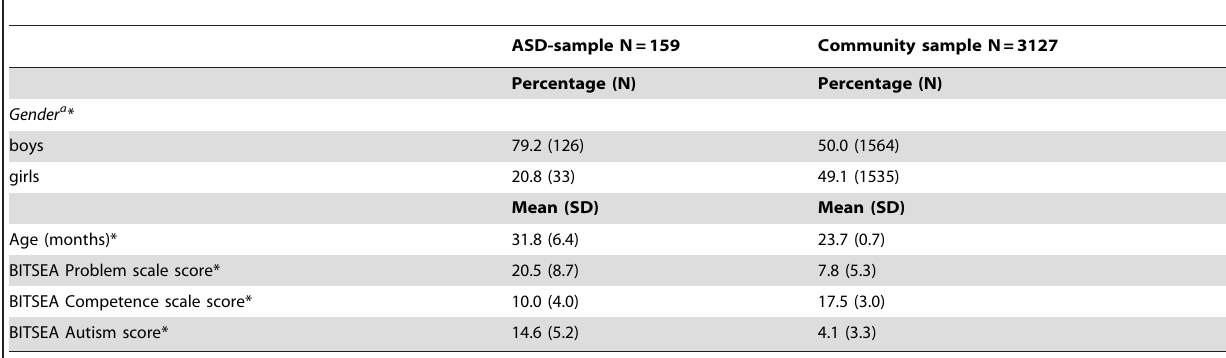
Table 1. Child characteristics of the autism spectrum disorder (ASD) sample and community sample.